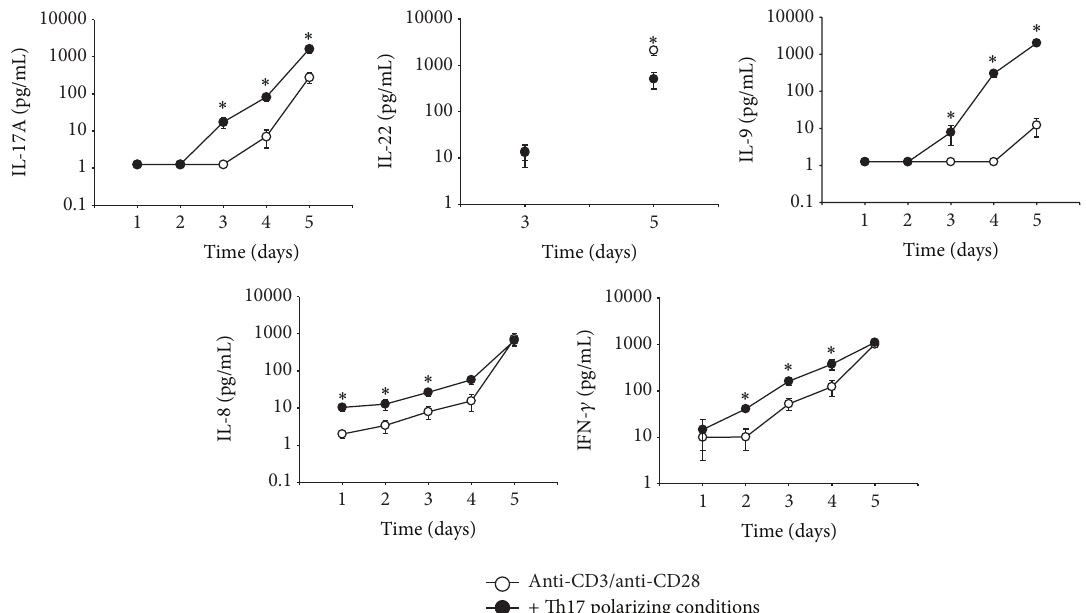
Figure 3: Effect of Th17 polarizing conditions on the cytokine secretion of CD4 + T cells. Human CD4 + T cells were cultured with anti- CD3/anti-CD28 with or without Th17 polarizing conditions for five days. The concentration of the indicated cytokines in the cell culture supernatant was measured by CBA (IL-17A, IL-9, IL-8, IFN- 𝛾 ) and ELISA (IL-22). The absolute concentration [pg/mL] of IL-17A, IL-22, IL-9, IL-8, and IFN- 𝛾 in the supernatant of CD4 + T cells cultured with anti-CD3/anti-CD28 ( I ) or in addition of Th17 polarizing conditions ( e ) during the time course is shown as mean ± SEM. ∗ represents significance, 𝑃 < 0.05 , Mann-Whitney 𝑈 test, and 𝑛 = 15